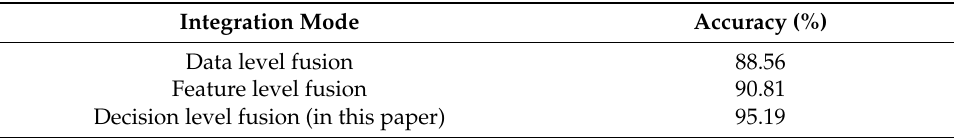
Table 6. Comparison of sensor fusion